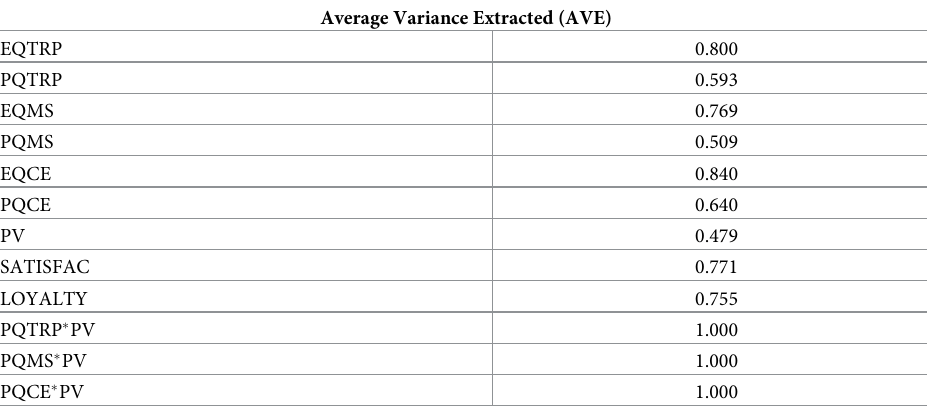
Table 7. Average variance